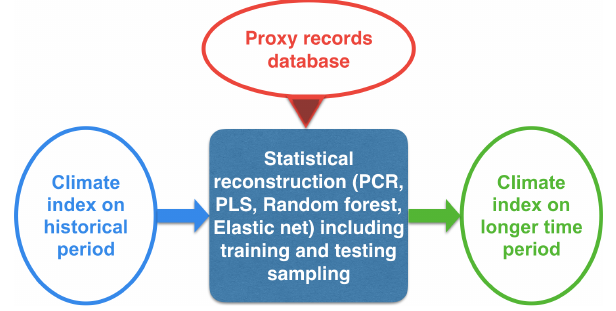
Figure 1. Scheme summarizing the main features of